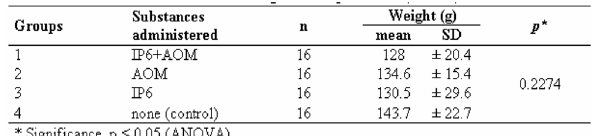
TABLE 3 - Weight gain during the experiment. Mean and standart deviation of the difference between final and initial weights. Campo Grande, Brazil, 2004.